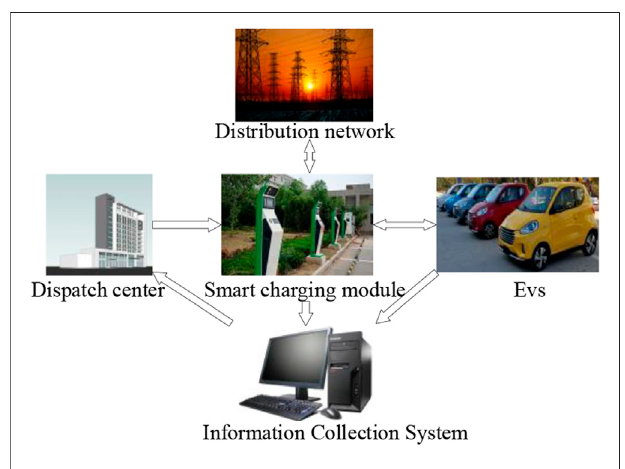
FIGURE 1 | Structure of